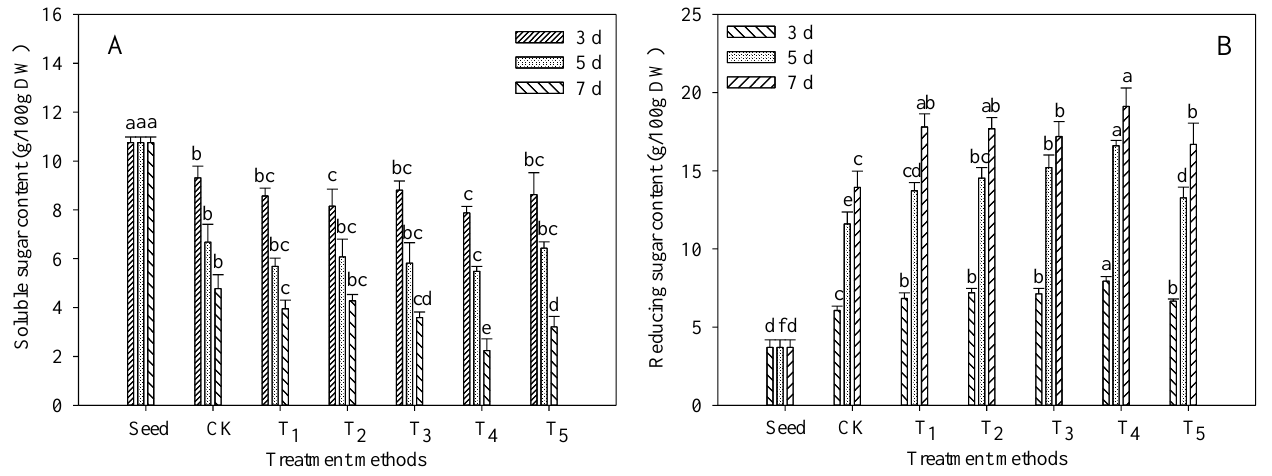
bb b Figure 2. Effect of exogenous additives on the soluble protein content of TB sprouts. Different lowercase letters indicate significant statistical difference ( p < 0.05). 3.3. Changes in Soluble Sugar and Reducing Sugar Contents Soluble sugar is the basis of plant metabolism and the main form of sugar metabo-